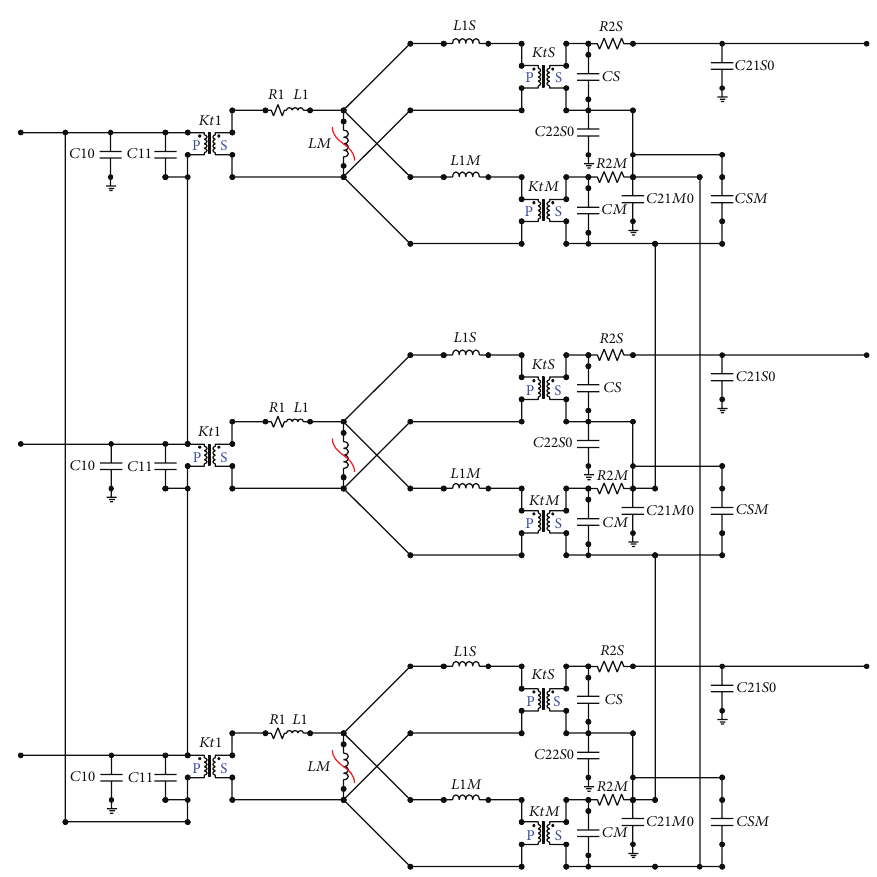
Figure 8: The equivalent circuit for the converter transformers considered in this study.